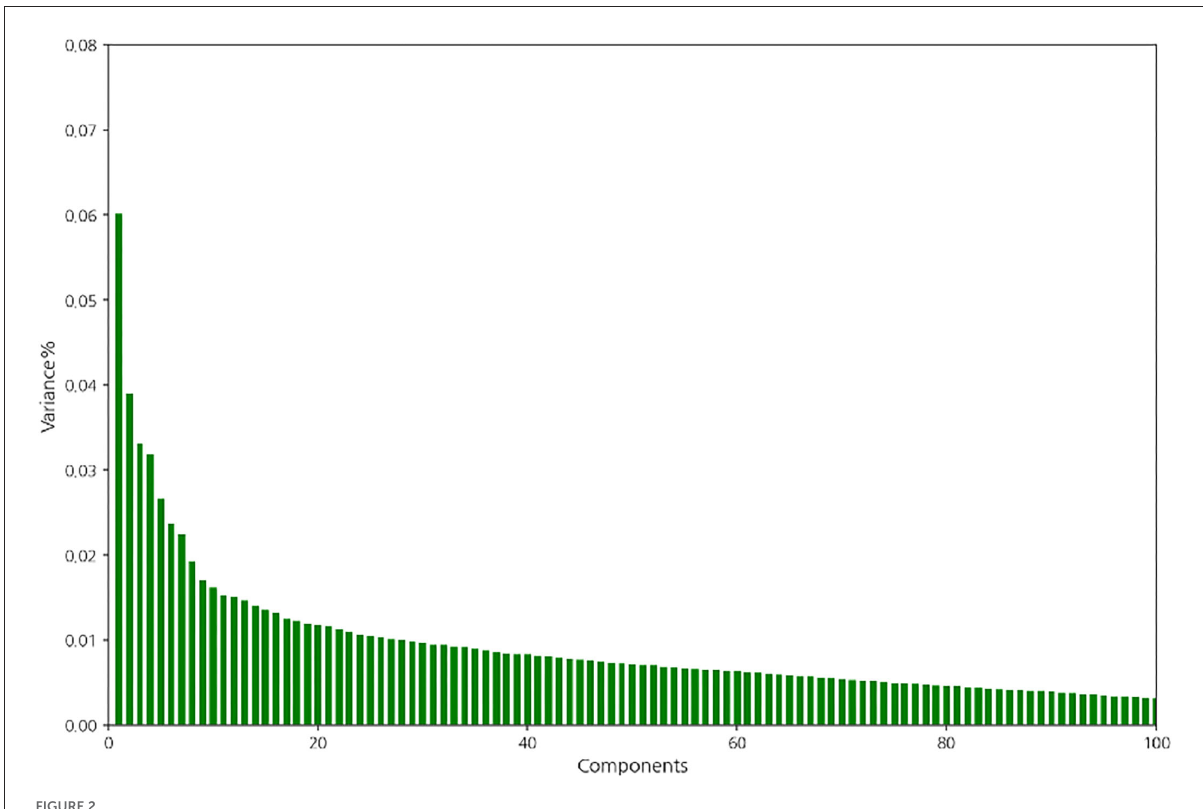
FIGURE2 Variance of the components in the training